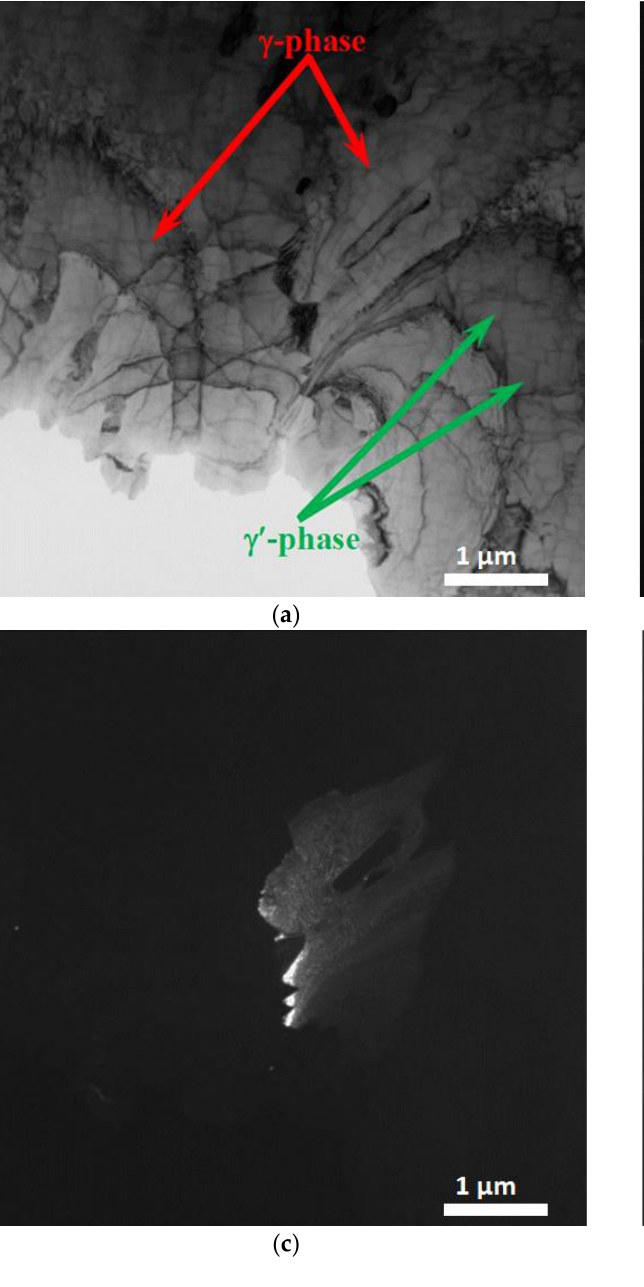
Figure 10. Fine structure of material of products obtained by wire-feed electron beam additive manufacturing at a distance from the substrate of 1 mm. Bright-field ( a ) and dark-field ( c , d ) TEM images, SAED and its identification scheme ( b ). Dark-field image taken in the reflection 002 γ & γ ’ ( c ) and 002MC ( d